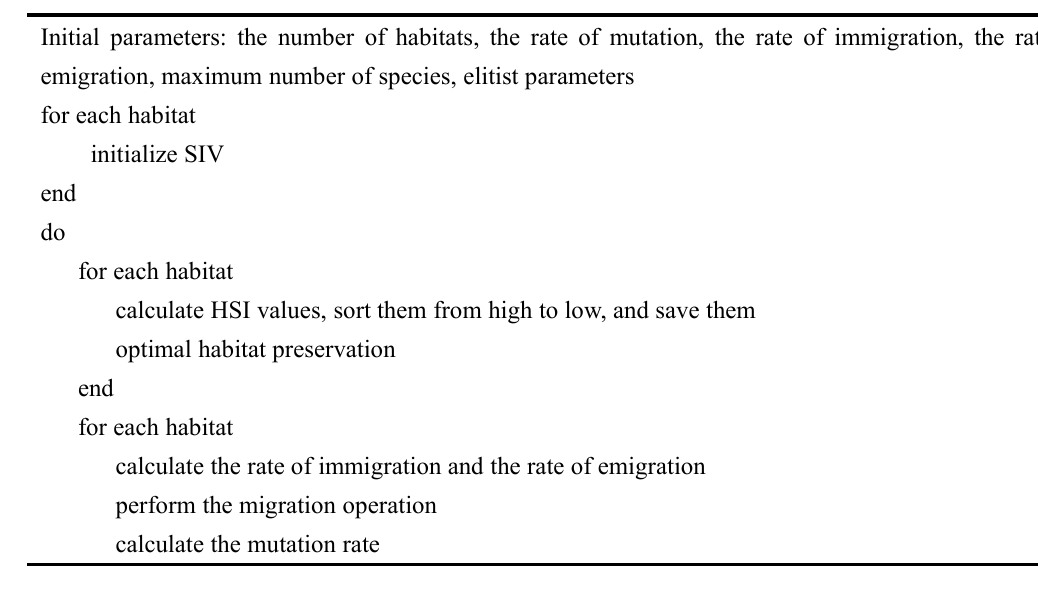
Table 2. Algorithm process Initial parameters: the number of habitats, the rate of mutation, the rate of immigration, the rate of emigration, maximum number of species, elitist